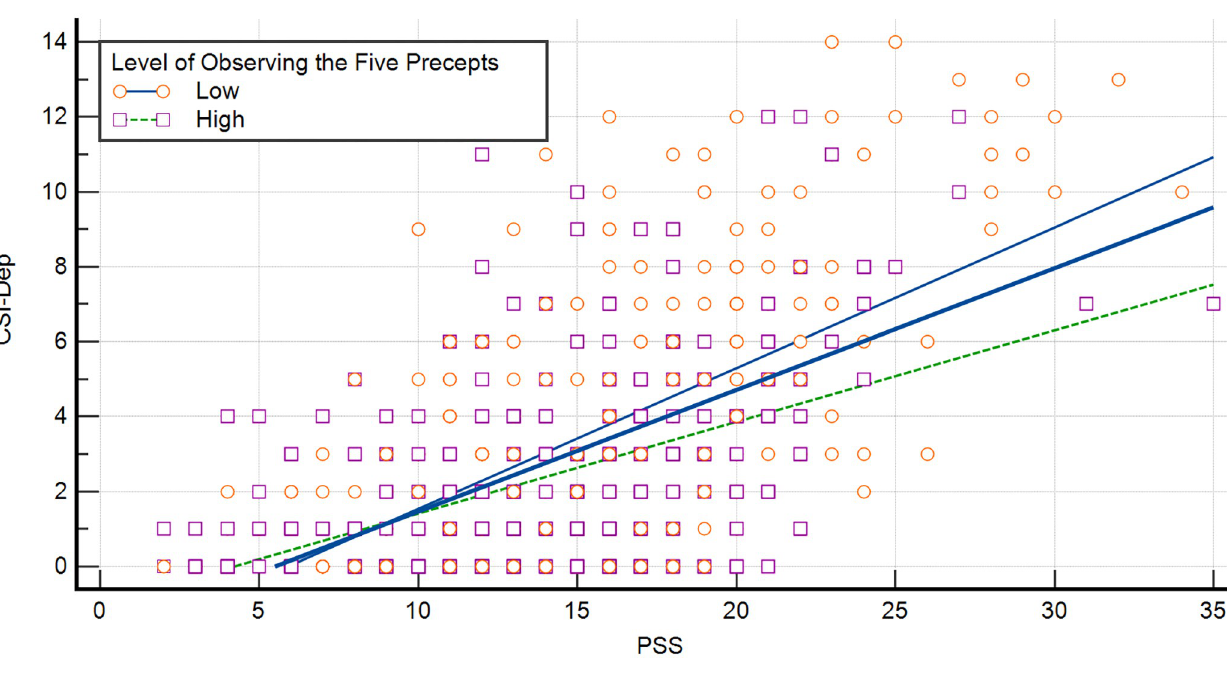
Fig 2. Regression lines between CSI–D and PSS scores based on the level of